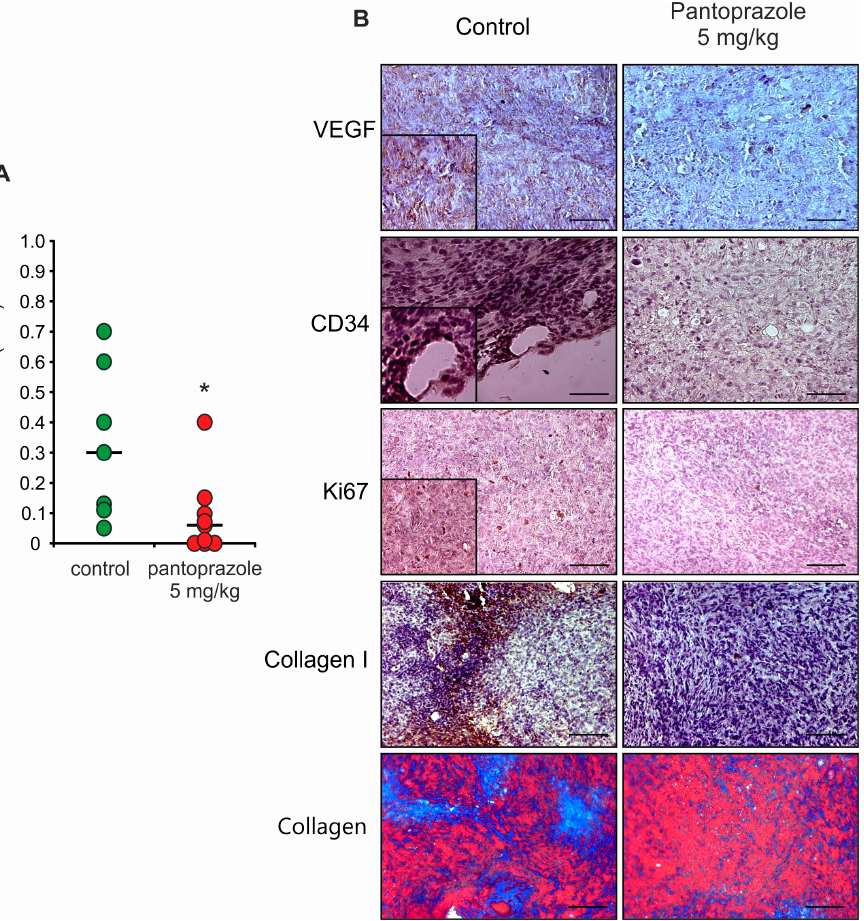
Figure 6. PPI treatment reduces tumor size in the orthotopic mouse model of pancreatic cancer. ( A ) Volume measurements of pancreatic tumor mass on mice transplanted with PANC-1 cells and treated with 5 mg / kg pantoprazole (red) or physiological saline solution (control, green). Horizontal bars show medians and circles are values for tumor size from individual mice. Asterisk indicates significant di ff erence (* p = 0.0266; Mann Whitney test) between control and animals treated with pantoprazole. ( B ) Representative pictures of tumor para ffi n sections from control and pantoprazole treated mice stained for vascular endothelial growth factor (VEGF) (Santa Cruz A-20, 1:100), CD34 (Cederlane, 1:100), Ki67 (Dako,1:50), collagen I (Abcam ab34710, 1:500) and collagen (Mallory’s Trichrome Connective Tissue Stain where collagen is stained with blue and nuclei with red). Inserts report a detail of the section, showing positivity for the VEGF, CD34, Ki67 proteins, acquired at higher magnification. Scale bars indicate 100 µ m. For more thorough analysis of parameters measured and details about histology scores see Table 1.